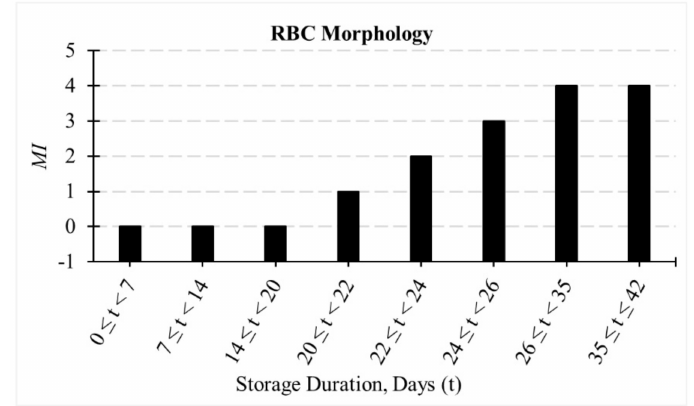
Figure 1. Evolution of RBC morphology during in-vitro storage duration. The morphology index ( MI ) corresponding to each RBC morphology is